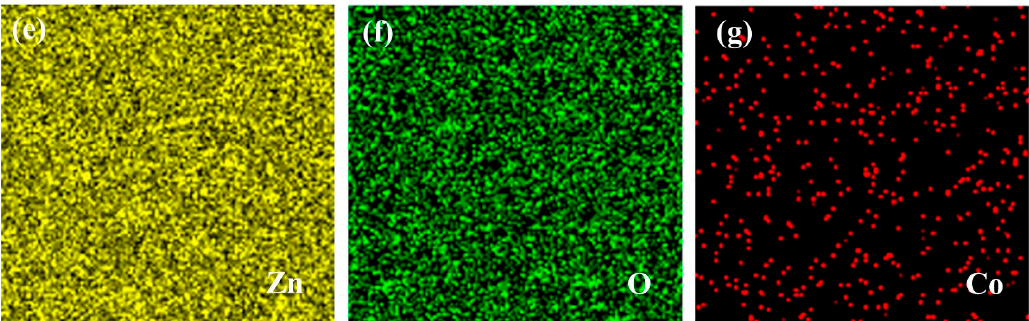
Figure 3. Field emission scanning electron microscopy images of ( a ) ZnO, ( b ) Co 3 O 4 / ZnO-2; ( c , d ) transmission electron microscopy and high resolution transmission electron microscope images of Co 3 O 4 / ZnO-2; ( e – g ) the energy dispersion spectrum of Co 3 O 4 / ZnO-2 (The two opposite arrows in Figure 3d were used to emphasize the spacing of the two parallel lines as the lattice spacing).